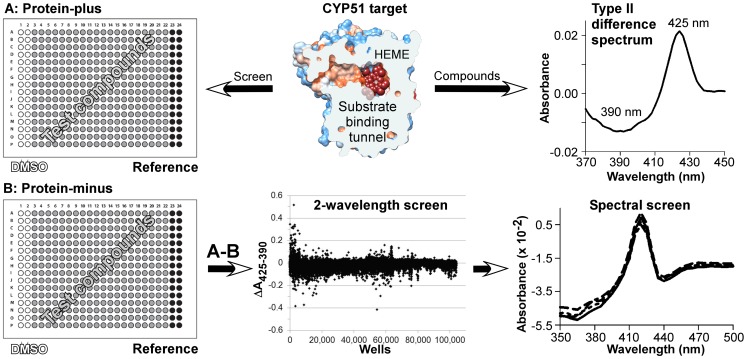
High throughput assay overview.
T. cruzi CYP51 target is shown clipped by plane through the substrate binding tunnel (top, center). Type II difference spectrum is recorded for 1 µM CYP51 at saturated concentration of reference compound (top, right). Screen plates were prepared in duplicate, A and B, with target protein loaded only in A set (left). HTS scatter plot shows absorbance differences of test compounds (ΔA = A425−A390) measured using the two-wavelength detection mode; each point represents a single test compound (bottom, center). Overlapped spectra are shown for a sub-micromolar hit re-evaluated in spectral mode at four serial dilutions (bottom, right).